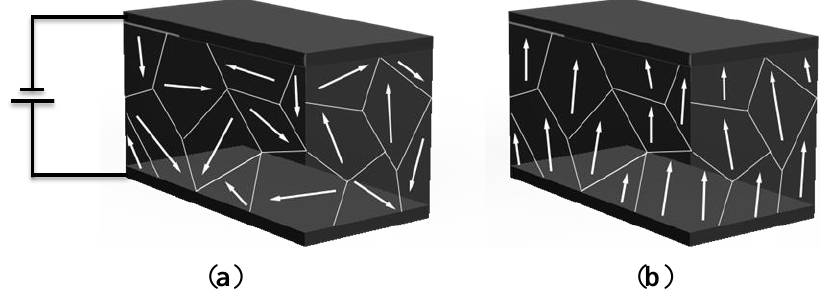
Figure 5. ( a ) Polarizations; ( b ) Surviving